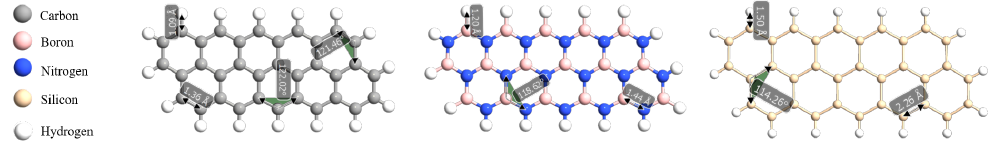
Figure 3. The optimized structure of the zigzag finite-length nanoribbons of ( left ) graphene, ( middle ) h-BN, and ( right ) silicene for (W, L) = (2,